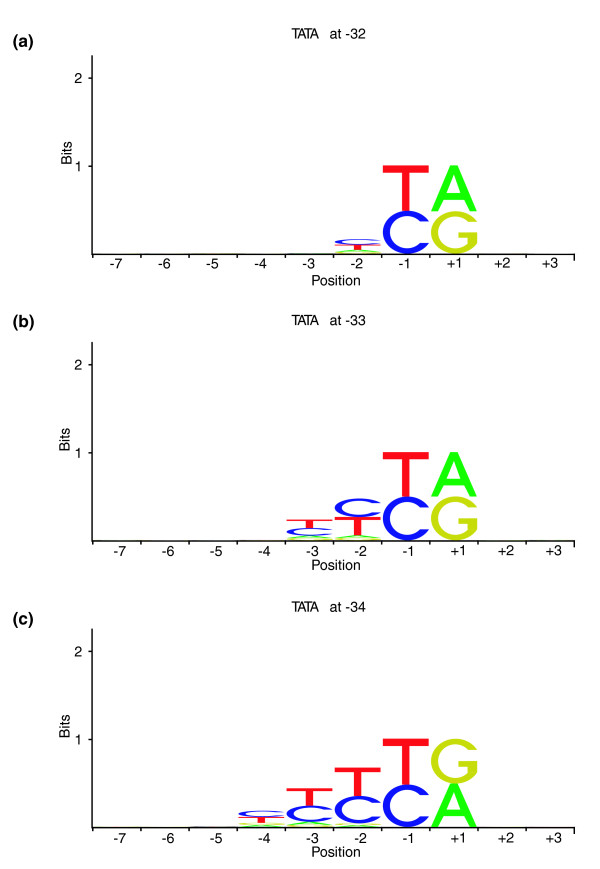
HMM simulations demonstrate increased signal strength as a result of PyPu depletion. Sequence logos resulting from sequence generation using an HMM incorporating rules for describing PyPu usage (see Materials and methods). Specifically, PyPu dinucleotides are not allowed in positions where they would introduce new initiation sites with more favorable TATA-TSS distances (-31, -32, and so on until the known spacing occurs). This results in an increase of Py nucleotides upstream of the TSS. bp, base pairs; HMM, Hidden Markov Model; Pu, purine; Py, pyrimidine; TSS, transcription start site.